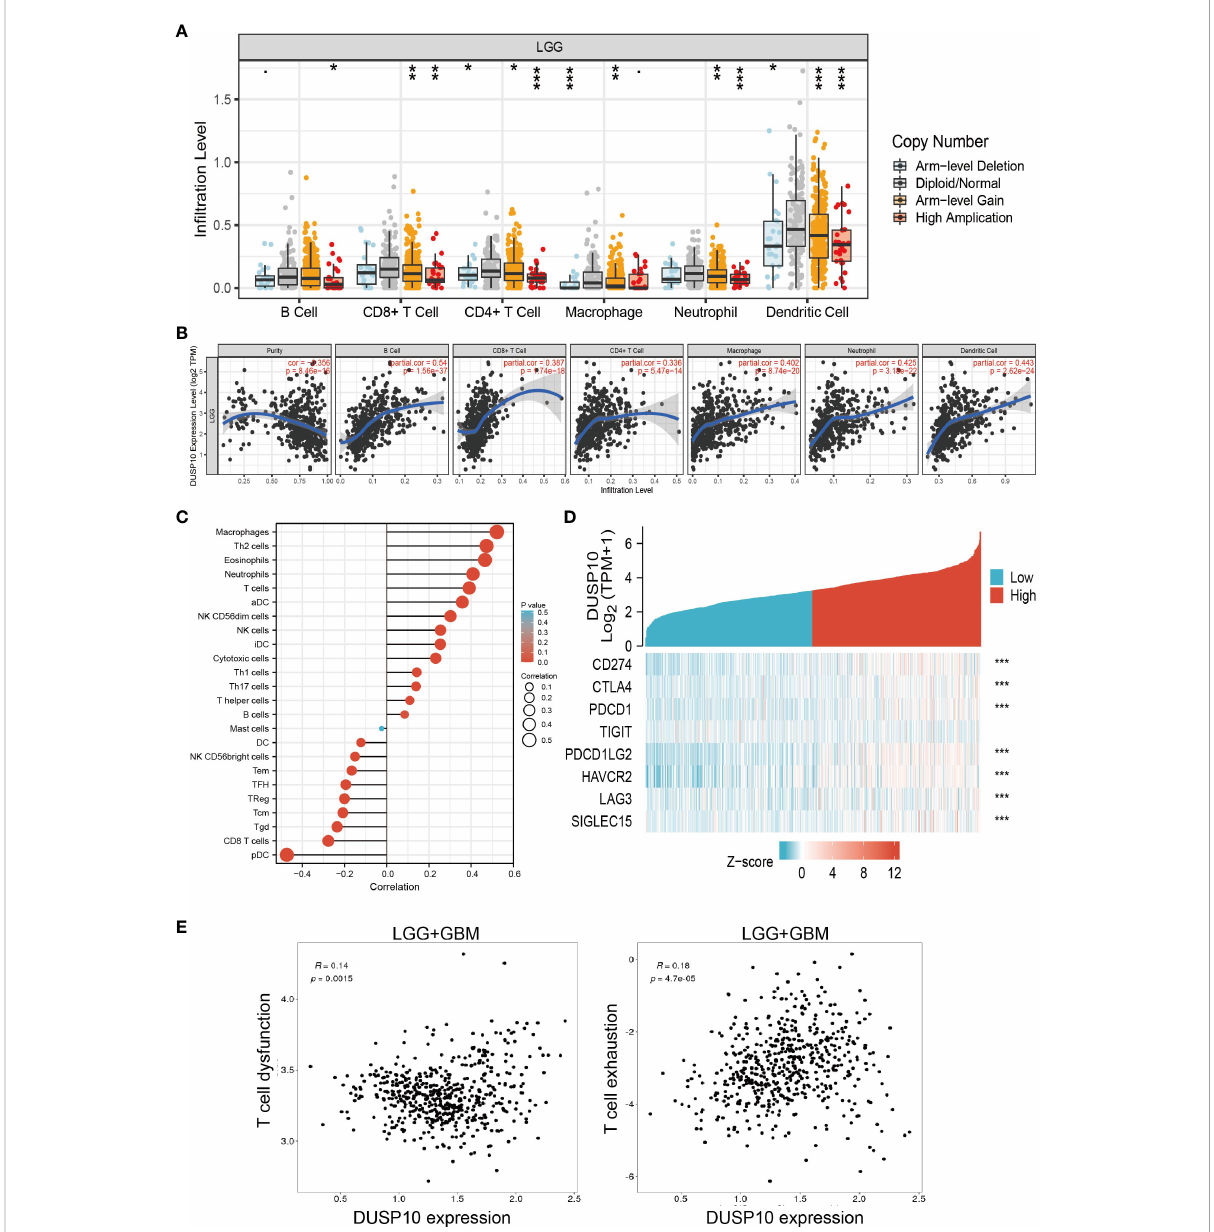
FIGURE 8 Relationships with DUSP10 in the tumor immune microenvironment from TCGA database. (A, B) DUSP10 is signi fi cantly associated with tumor purity and is positively correlated with the in fi ltration of different immune cells using the TIMER database. (C) Correlation analysis of DUSP10 gene expression and in fi ltration of various types of immune cells. (D) Correlation analysis of DUSP10 gene expression and the immune checkpoint biomarkers. (E) Correlation between immune cell and glioma patients ’ clinical outcomes. * p < 0.05, ** p < 0.01, *** p < 0.001. TCGA, The Cancer Genome